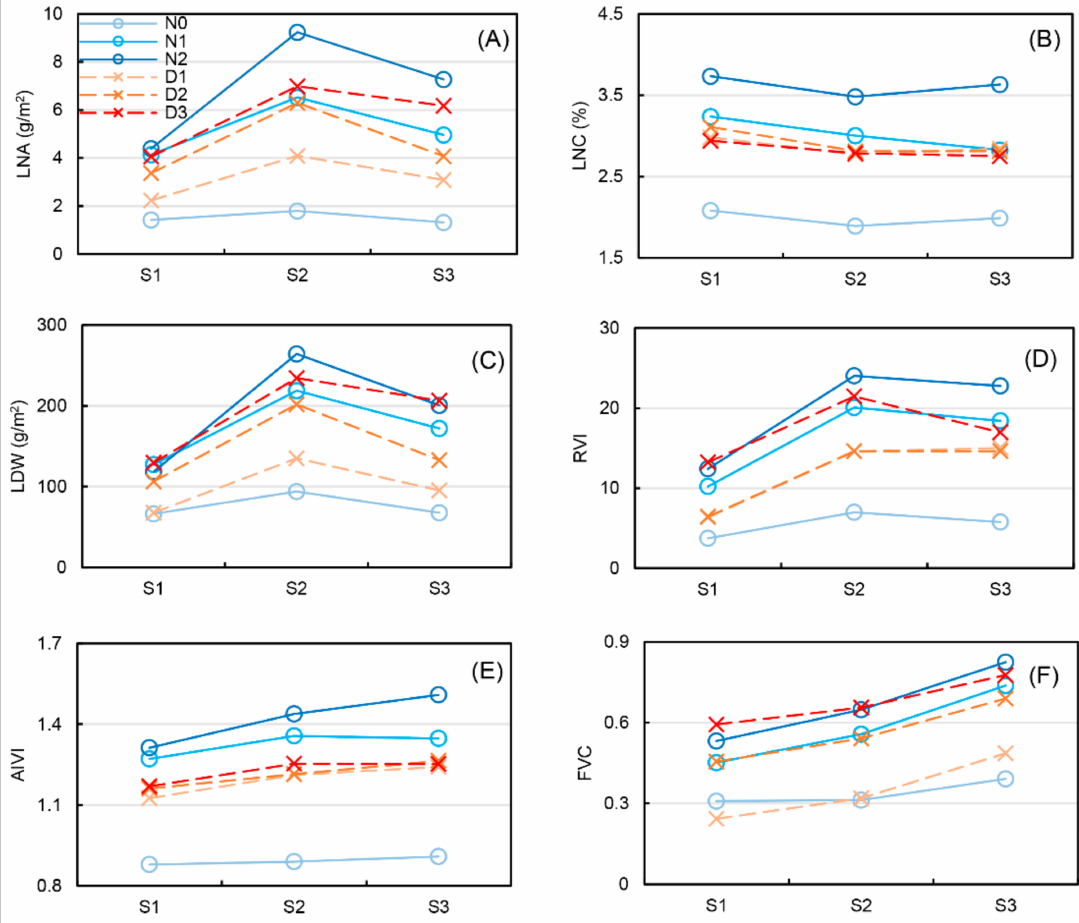
Figure 9. Dynamic changes in LNA ( A ), LNC ( B ), LDW ( C ), RVI ( D ), AIVI ( E ) and FVC ( F ); S1, S2, and S3 represent the jointing stage, booting stage, and heading stage,